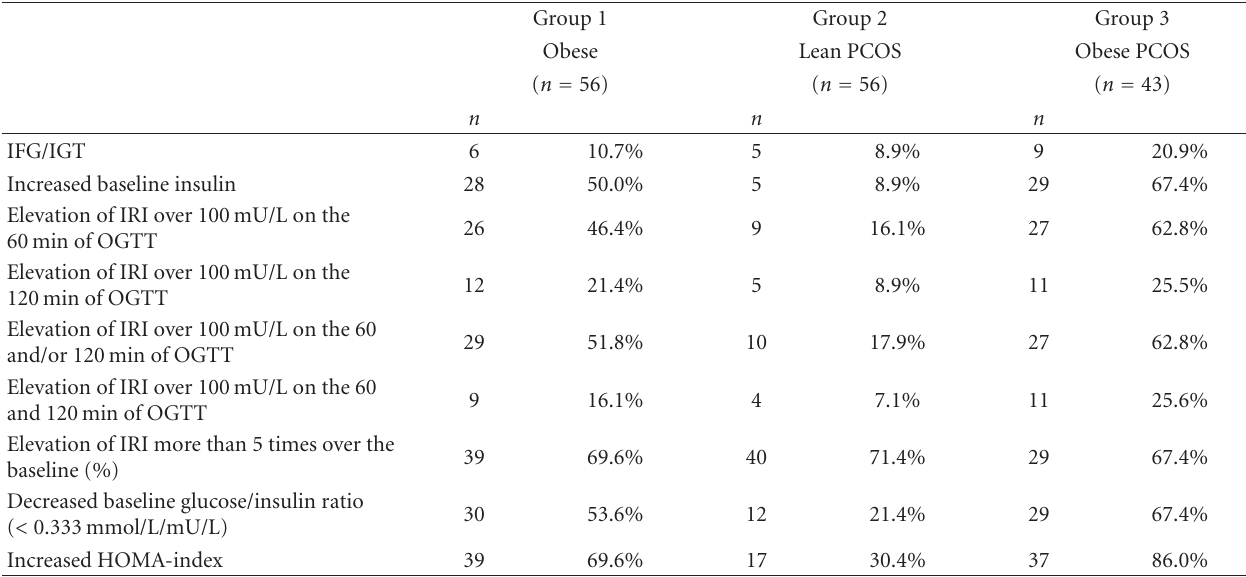
Table 9: Insulin resistance according to di ff erent